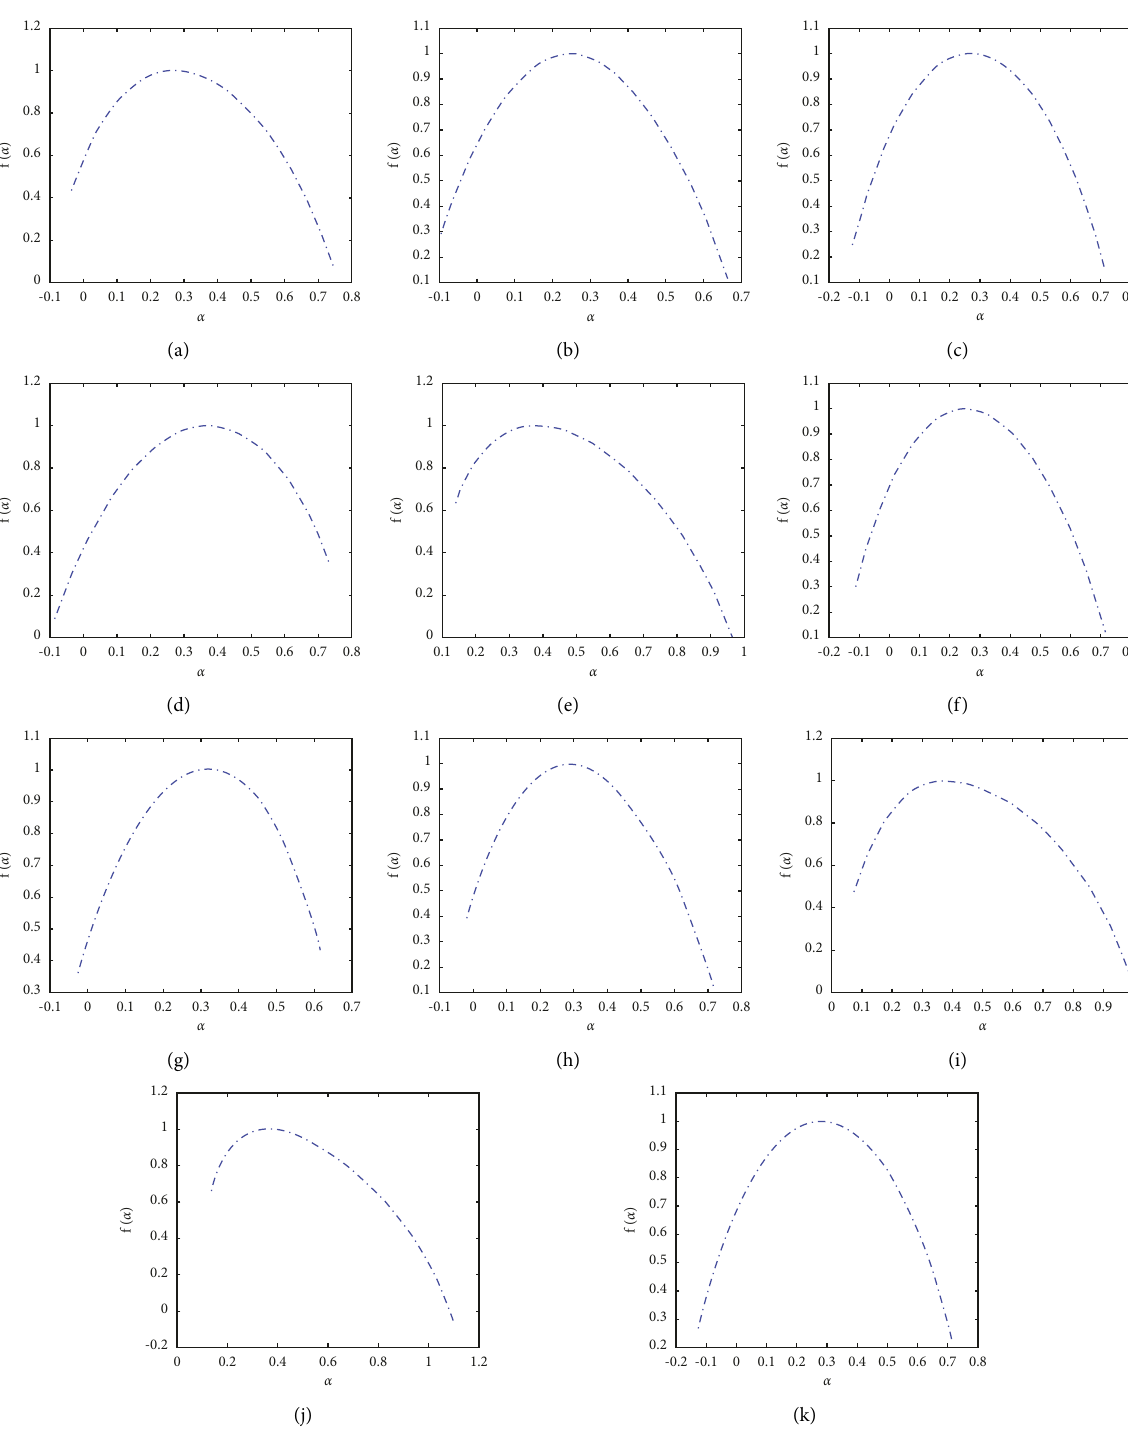
Figure 9: The multifractal spectra of each MATV series for all the sectors. (a) Communication service. (b) Consumer discretionary. (c) Consumer staples. (d) Energy. (e) Financials. (f) Health care. (g) Industrials. (h) Information technology. (i) Materials. (j) Real estate. (k)